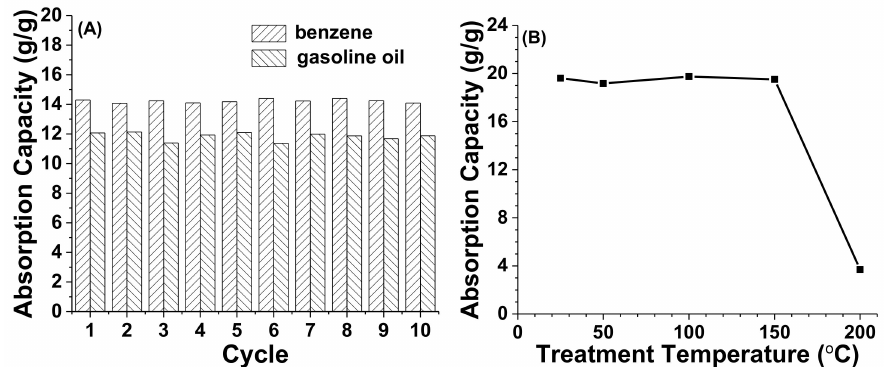
Figure 6. ( A ) Variation of absorption capacity of the C-63p2 cryogel with the absorption cycle for benzene and gasoline oil; ( B ) absorption capacity of C-63p4 for benzene after treatment with various